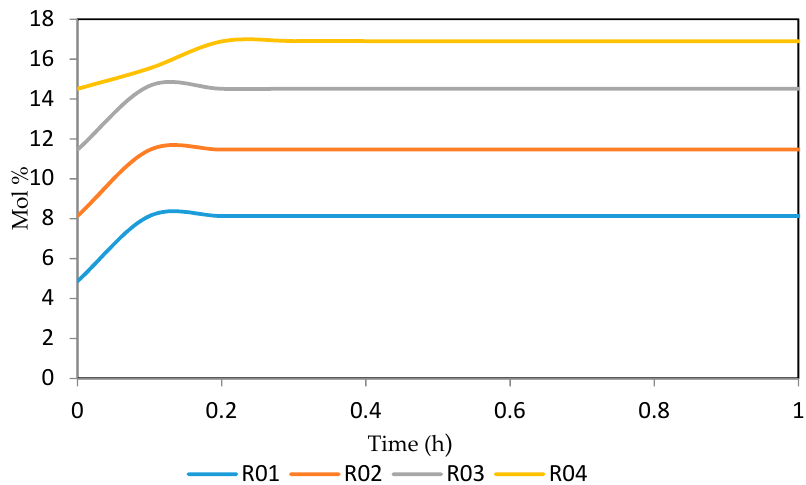
Figure 26. Dynamic behaviour of A 6 in the four reactors.